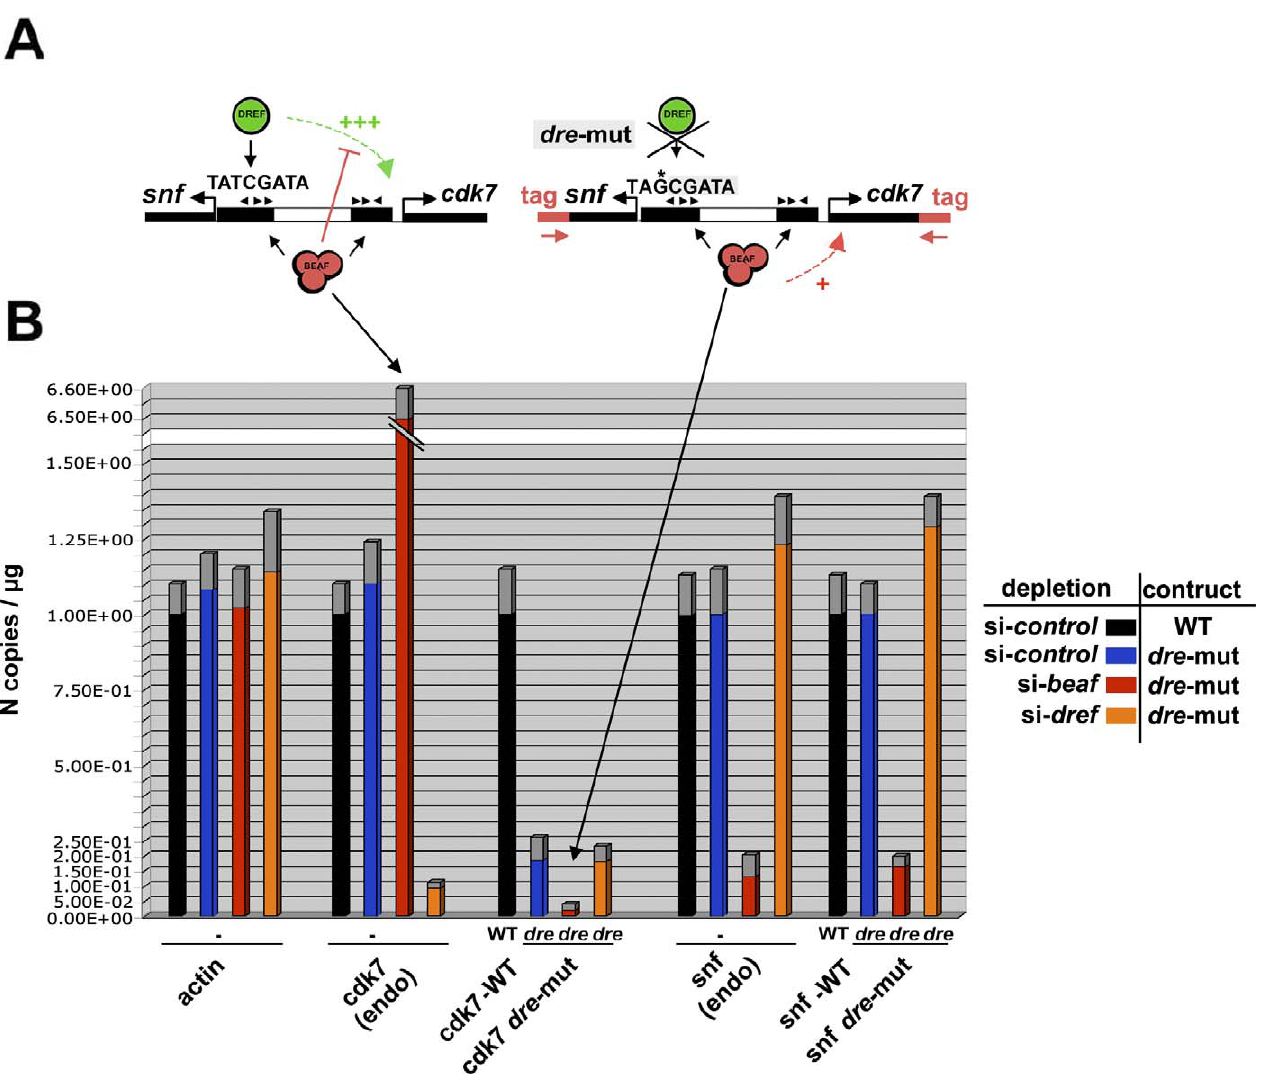
Figure 5. BEAF Dual-Cores Have a Positive Effect on Gene Expression Independent of DREF (A) Schematic representation of the transfected constructs potentially regulated by BEAF–DREF competition for binding to the consensus TATCGATA present in the dual-core_D associated with cdk7 and snf (X_Dcore 38D). Both the wild-type (left) and its DREF-response element ( dre ) mutant form (right) are shown. The transfected Dual-core harbors an additional sequence (tag) for specific amplification by Q-PCR. The þþþ sign indicates the activation of cdk7 by DREF, and the þ sign represents the positive effect of BEAF obtained in the absence of the DREF binding site (B). (B) Quantitative RT-PCR analysis in control (black and blue bars), BEAF-depleted (red bars), or DREF-depleted cells (orange bars) of the expression of endogenous genes ( actin ; cdk7 - endo ; snf - endo ) and of transfected genes associated with the wild-type (WT) or the mutated version ( dre ; without DREF binding site) of Dcore_38D, as indicated. The y -axis shows the number of copies of amplification products per l g of RNA normalized for each gene in control cells, where the copy number N ¼ 1 corresponds to 9,680 copies of actin , 93,690 copies of snf , 138,900 copies of cdk7 . Note that the expression of the transgenes (WT or dre ) and of endogenous genes was measured from the same batch of cells. For transfected constructs, gene expression was normalized to the DNA copy-number in the input (for details, see Materials and Methods). Experimental error is denoted by the differentially colored (gray) portion at the top of each bar.